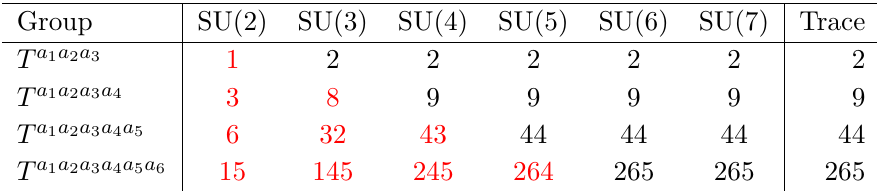
Table 3 . The number of independent rank- N invariant tensors for various groups SU( N f ) . In the last column, we also present the number of inequivalent trace structures, i.e., those not related by cyclic permutations. Cayley-Hamilton theorem reduces the number for N red